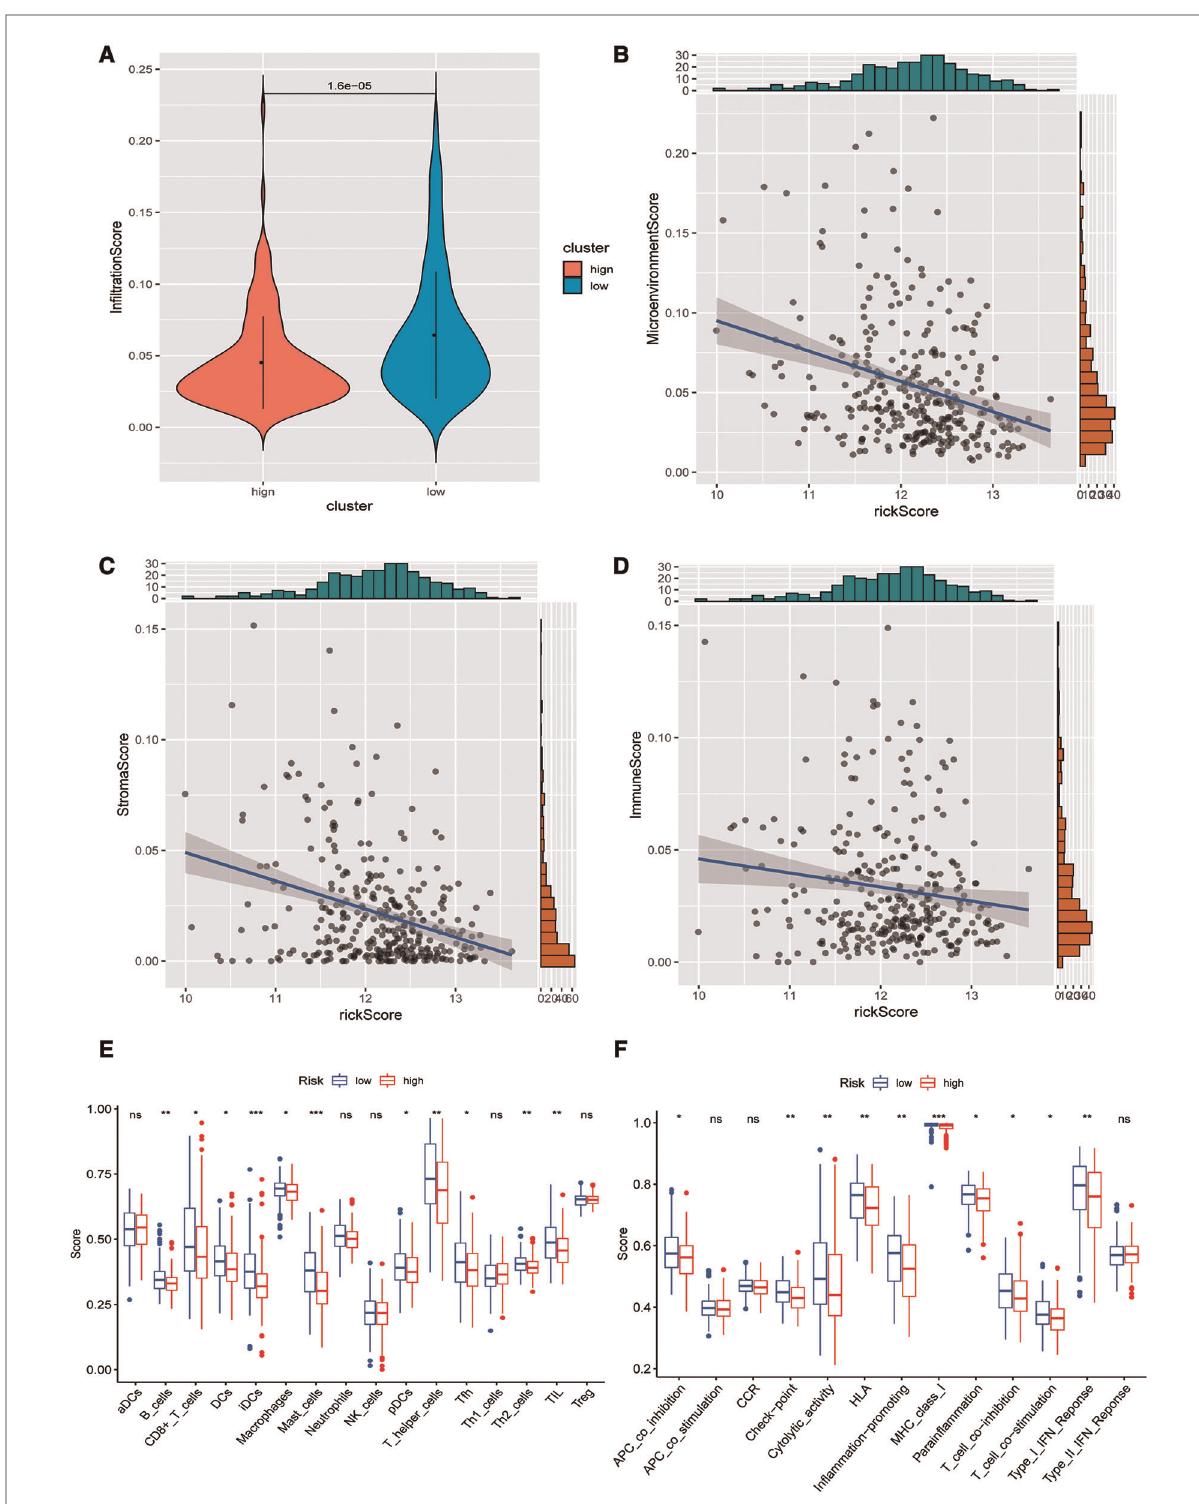
FIGURE 5 Analysis of immune in fi ltration levels. ( A ) Comparison of immune microenvironments between high and low-risk groups. ( B – D ) Scatter plot of the correlation between total score, stromal cell score, immune cell score, and risk score in the microenvironment. ( E ) Difference between groups at high or low risk of Oral squamous cell carcinoma under different immune cell types. ( F ) Differences between groups at high and low risk of OSCC under different activated immune